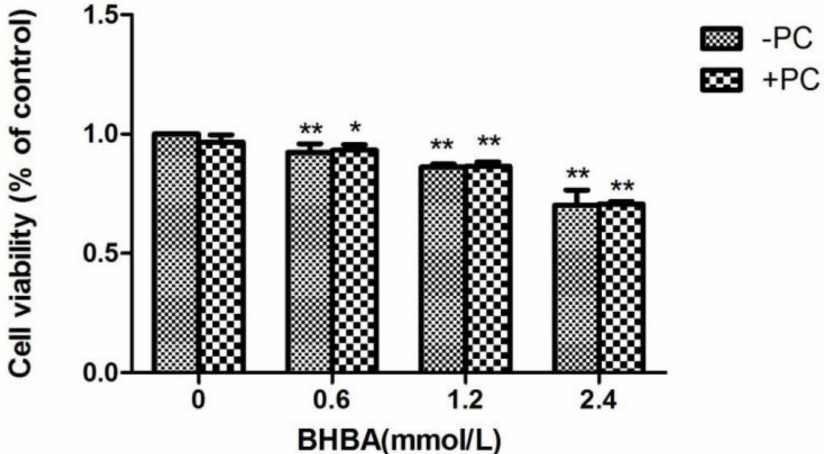
Figure 4. Effects of different BHBA concentrations and PCs pretreatment on the relative viability of BEND cells. * p < 0.05 vs. control group, ** p < 0.01 vs. control